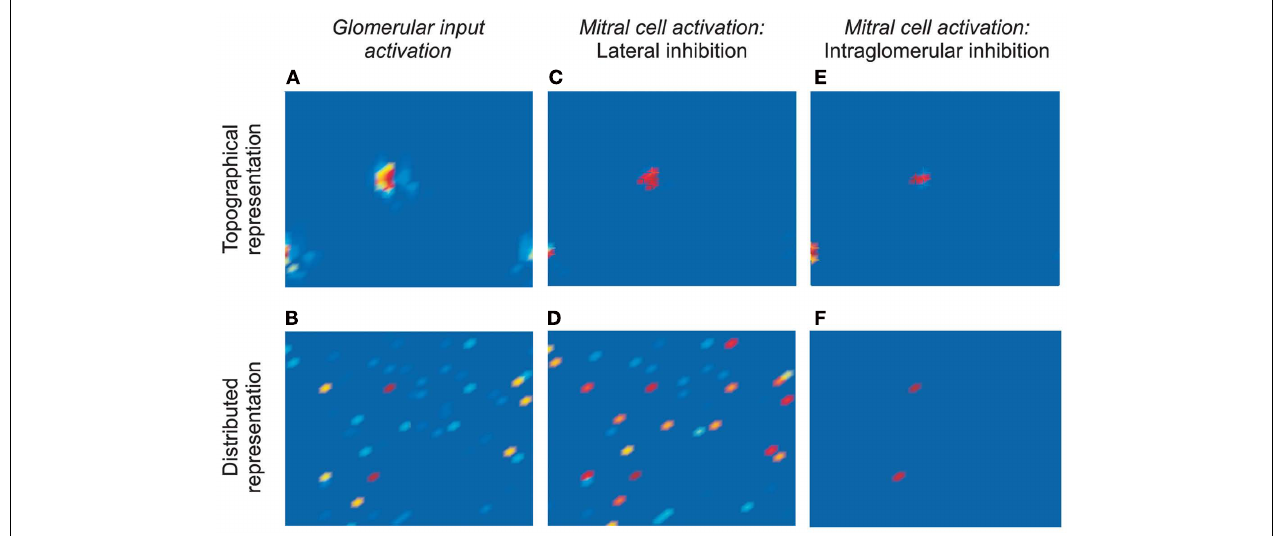
the most strongly activated mitral cells remain active. (D) Response of the 32 × 32 array of mitral cells in the distributed representation scenario after the effects of lateral inhibition are incorporated.The mitral cell activation profile is broad and disorganized, with an unclear relationship to the pre-inhibition representation. (E) Response of the 32 × 32 array of mitral cells in the topographical representation scenario after the effects of intraglomerular local inhibition are incorporated.The mitral cell activation profile is sharper and narrower at each of the two clusters, such that only the most strongly activated mitral cells remain active – replicating the effect of lateral inhibition in this scenario. (F) Response of the 32 × 32 array of mitral cells in the distributed representation scenario after the effects of intraglomerular local inhibition are incorporated.The mitral cell activation profile is sharper and narrower, such that only the most strongly activated mitral cells remain active. (C,E,F) depict effective decorrelation of the input